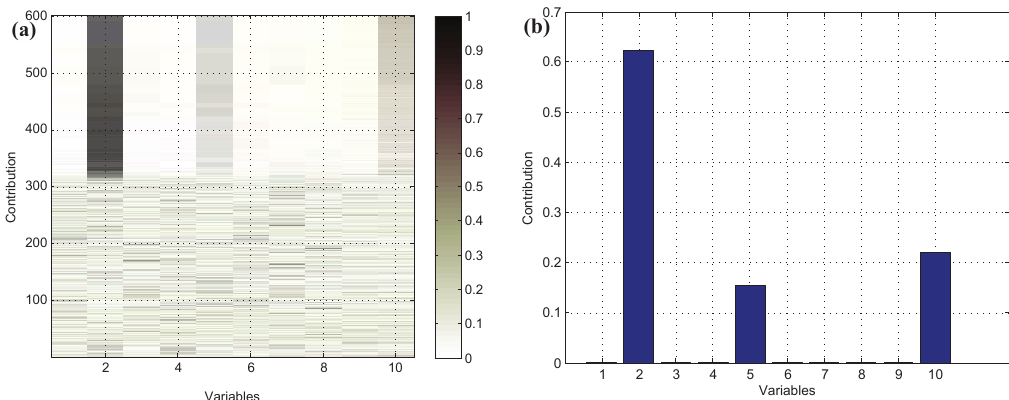
Figure 12. Fault detection result of F 1 .